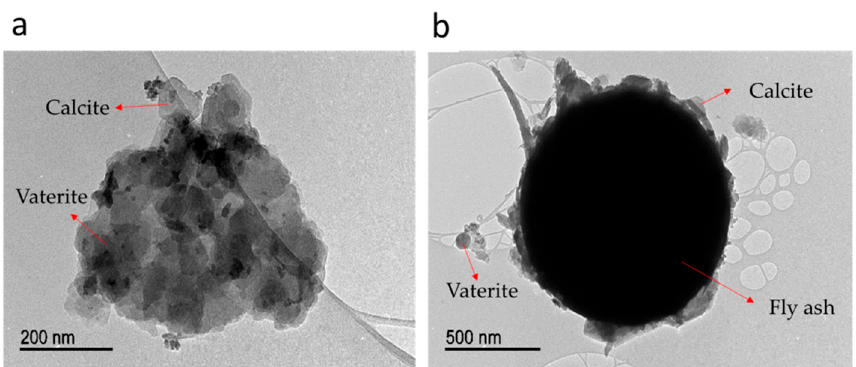
Figure 7. TEM micrographs of bioconsolidation of ( a ) sand, and ( b ) fly ash at 50 W-50 NB. These images show vaterite and calcite crystals on these material’s surface, such as biocement.